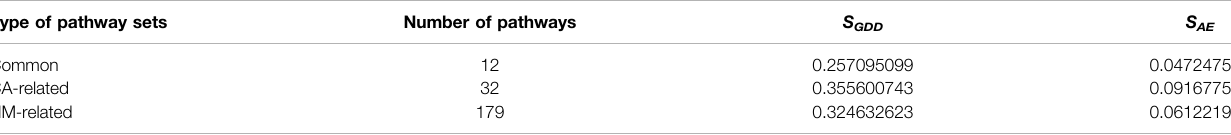
TABLE 1 | Pathway similarity results of different pathways. Type of pathway sets Number of pathways